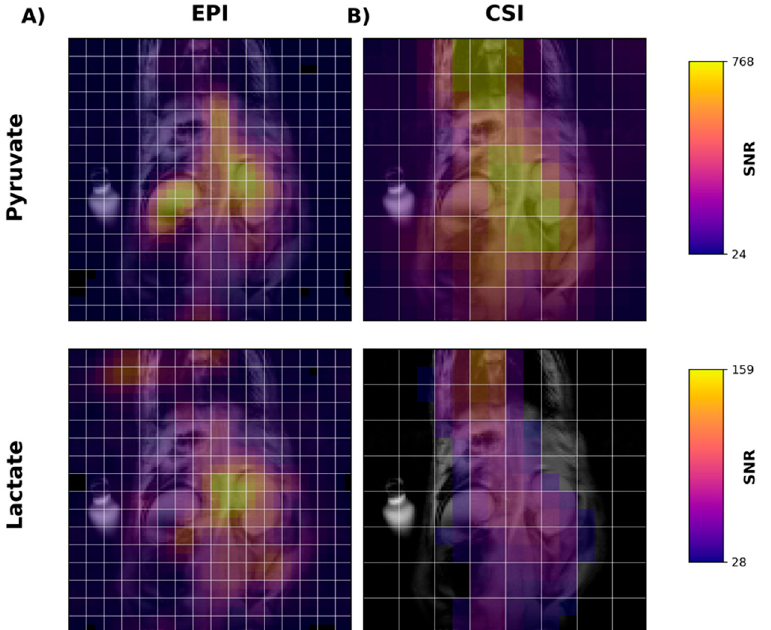
Figure 4. Metabolite images of [1- 13 C]pyruvate (1st row) and [1- 13 C]lactate (2nd row) in the liver and kidney of a rat following injection of [1- 13 C]pyruvate. Images in the first column ( A ) were acquired using metabolite-specific EPI (Figure 1), while images in the second column ( B ) were acquired using a traditional CSI sequence. All images were obtained by summing the signal over all time points. White lines are acquisition grids for each image. Images are shown after a 2x linear interpolation followed by nearest neighbor interpolation. EPI images required 4x nearest neighbor interpolation and CSI 8x. Color scale shows each metabolite in SNR units.